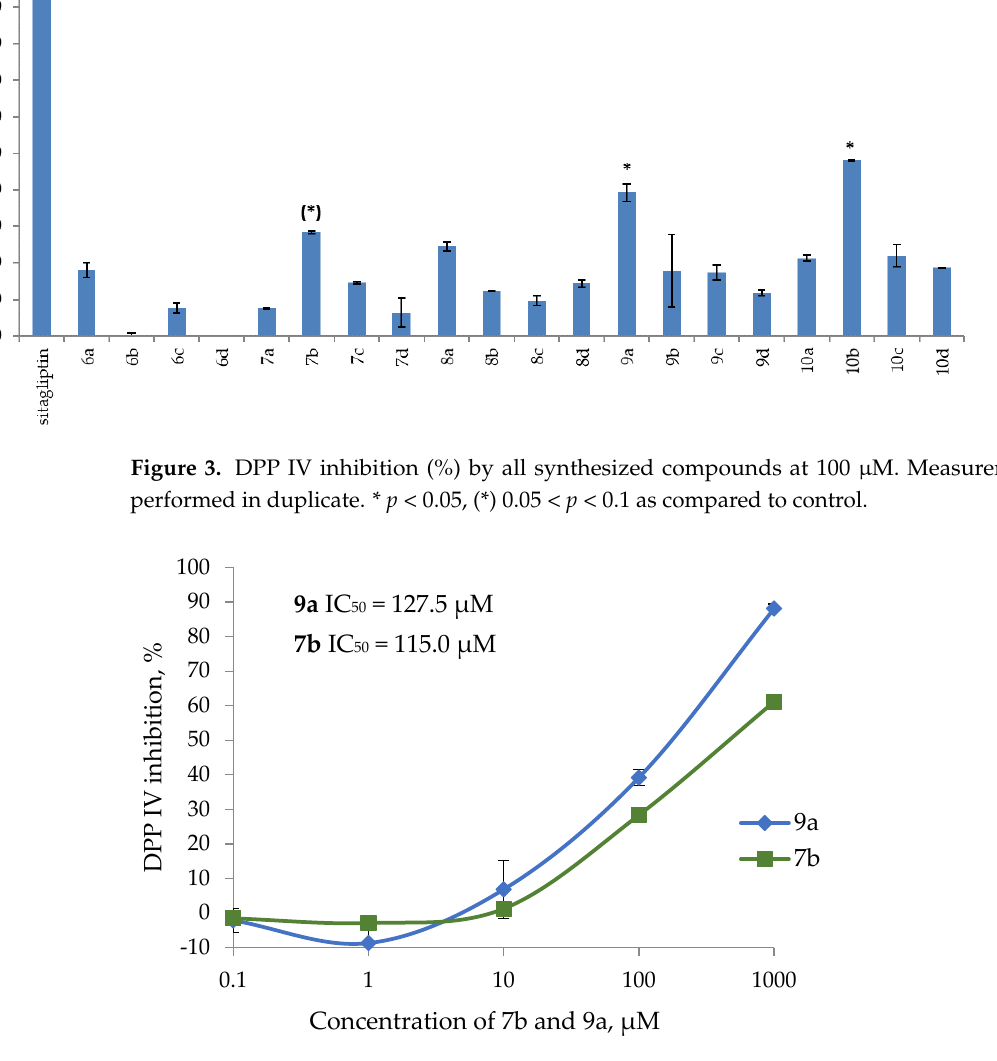
Figure 4. DPP IV inhibition (%) by 7b and 9a at concentration 0.1–1000 µ M. Measurements were performed in duplicate. IC 50 was calculated using a four-parameter logistic regression model.